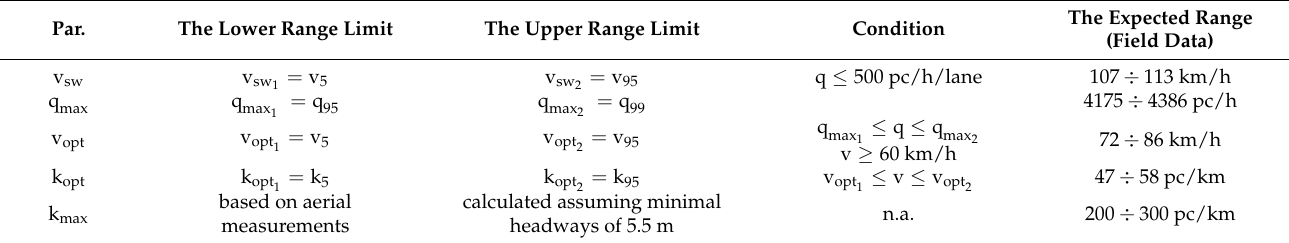
Table 3. Determining the expected range of boundary parameter values from an averaged representation of traffic conditions. Par. The Lower Range Limit The Upper Range Limit Condition